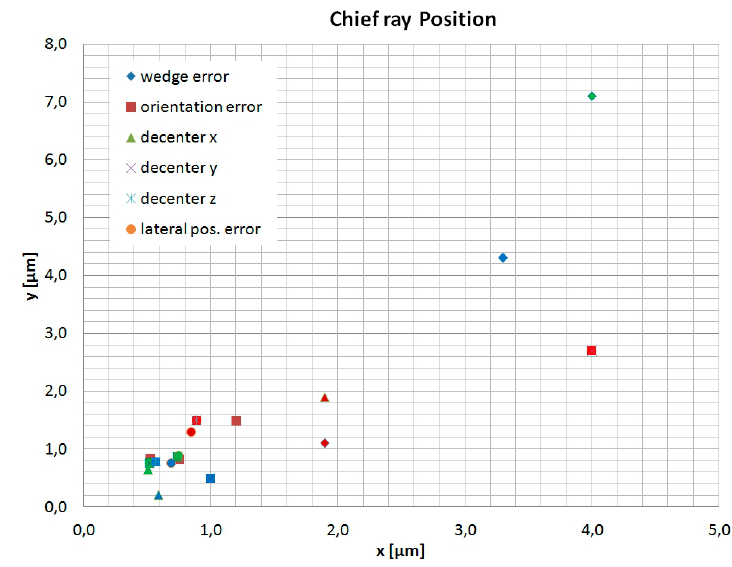
Figure 15. Chief ray positions for the individual position errors of the freeform optics for three different adjustments of refraction power: − 0.8 dpt (red), 1.5 dpt (blue), and 3.0 dpt (green).